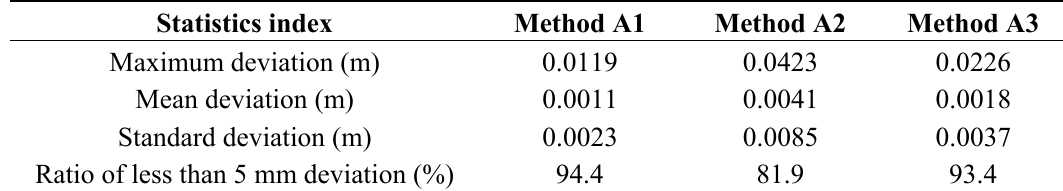
Table 2. Accuracy using the acceleration data processing method.